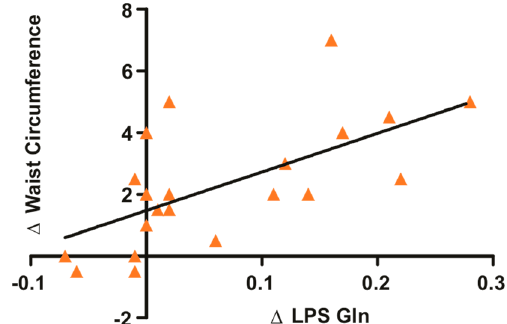
Figure 1. Positive correlation between the reduction of waist circumference (WC) and serum lipopolysaccharide (LPS) of obese and overweight humans. The Pearson Correlation test was used (r = 0.629).